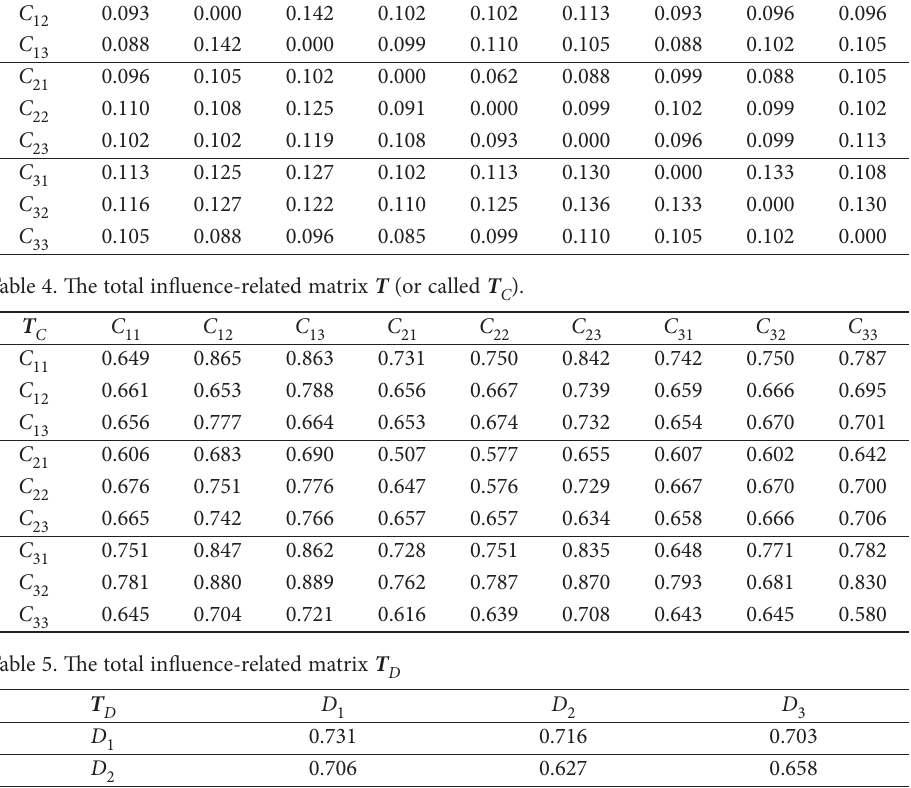
Table 3. Normalized influence-related matrix X